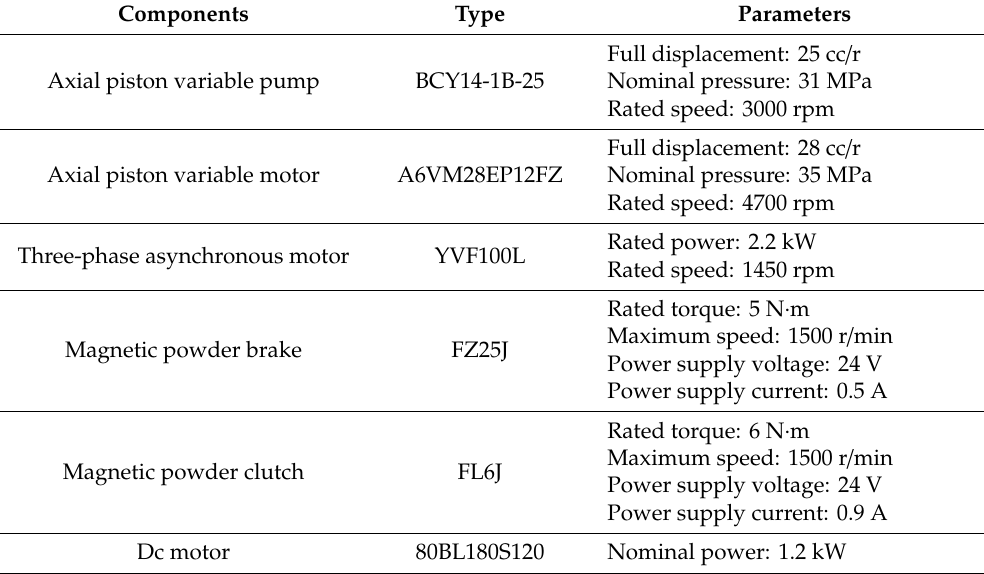
Figure 3. Test station of the wind-motor system. Table 1. Parameters of the experimental main components.